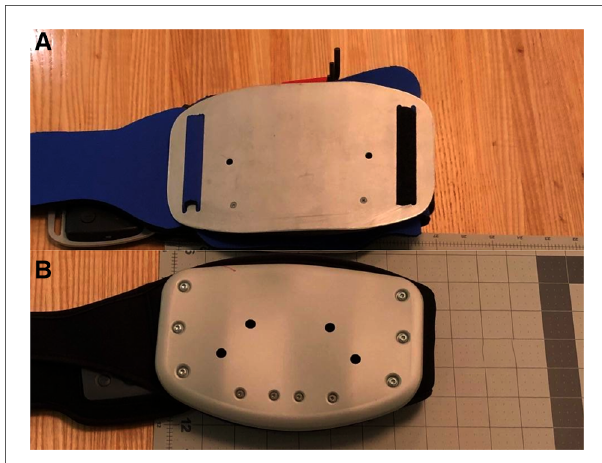
FIGURE 1 Device design iterations: ( A ) the motor chassis is attached to a thermoconductive single-curve metal plate ( B ) motors are directly attached to a rounded multi-curved